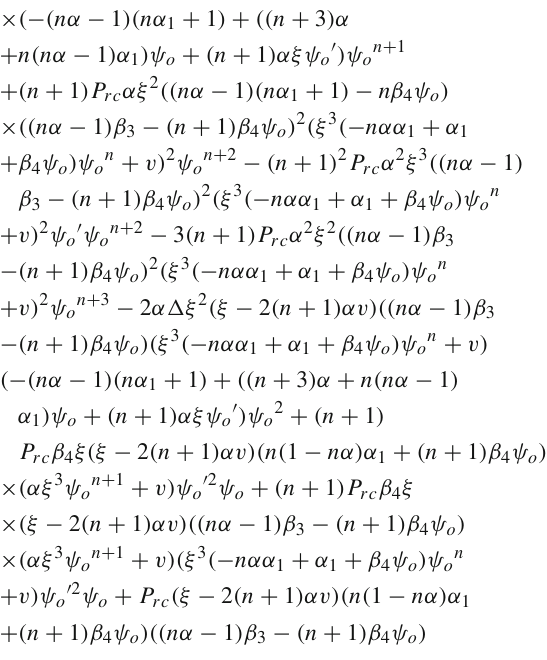
Fig. 1 Graphs between ξ and v ; for α 1 = . 5, n = 1 and α = 10 − 10 (curve a ); α = 2 × 10 − 10 (curve b ); α = 4 × 10 − 10 (curve c ) and α = 8 × 10 − 10 (curve d ) ψ (ξ = 0 ) = 1 and v(ξ = 0 ) = 0 . o